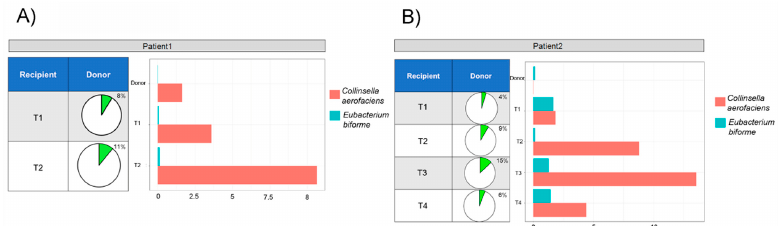
Figure 2. Donor’s OTUs inherited from patients. The percentage and relative abundance of donor species within P1 ( A ) and P2 ( B ) microbiota acquired through FMT. Pie charts indicate sum of percentage